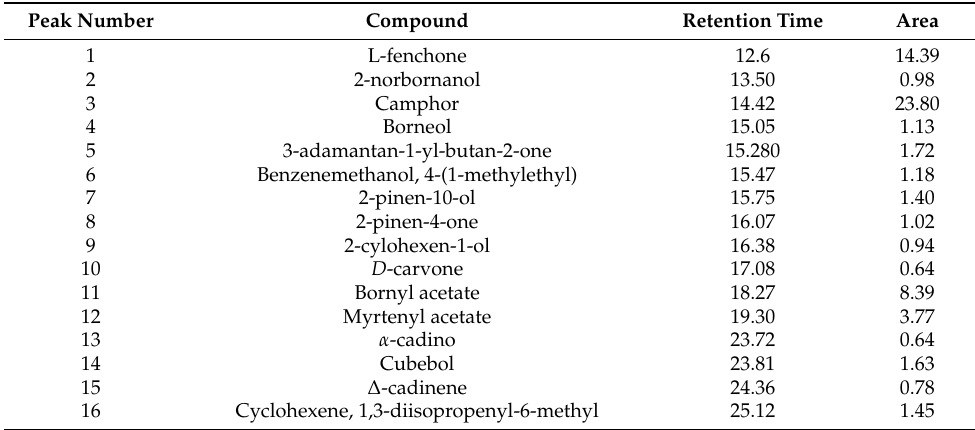
Table 1. Chemical composition of LSEO A